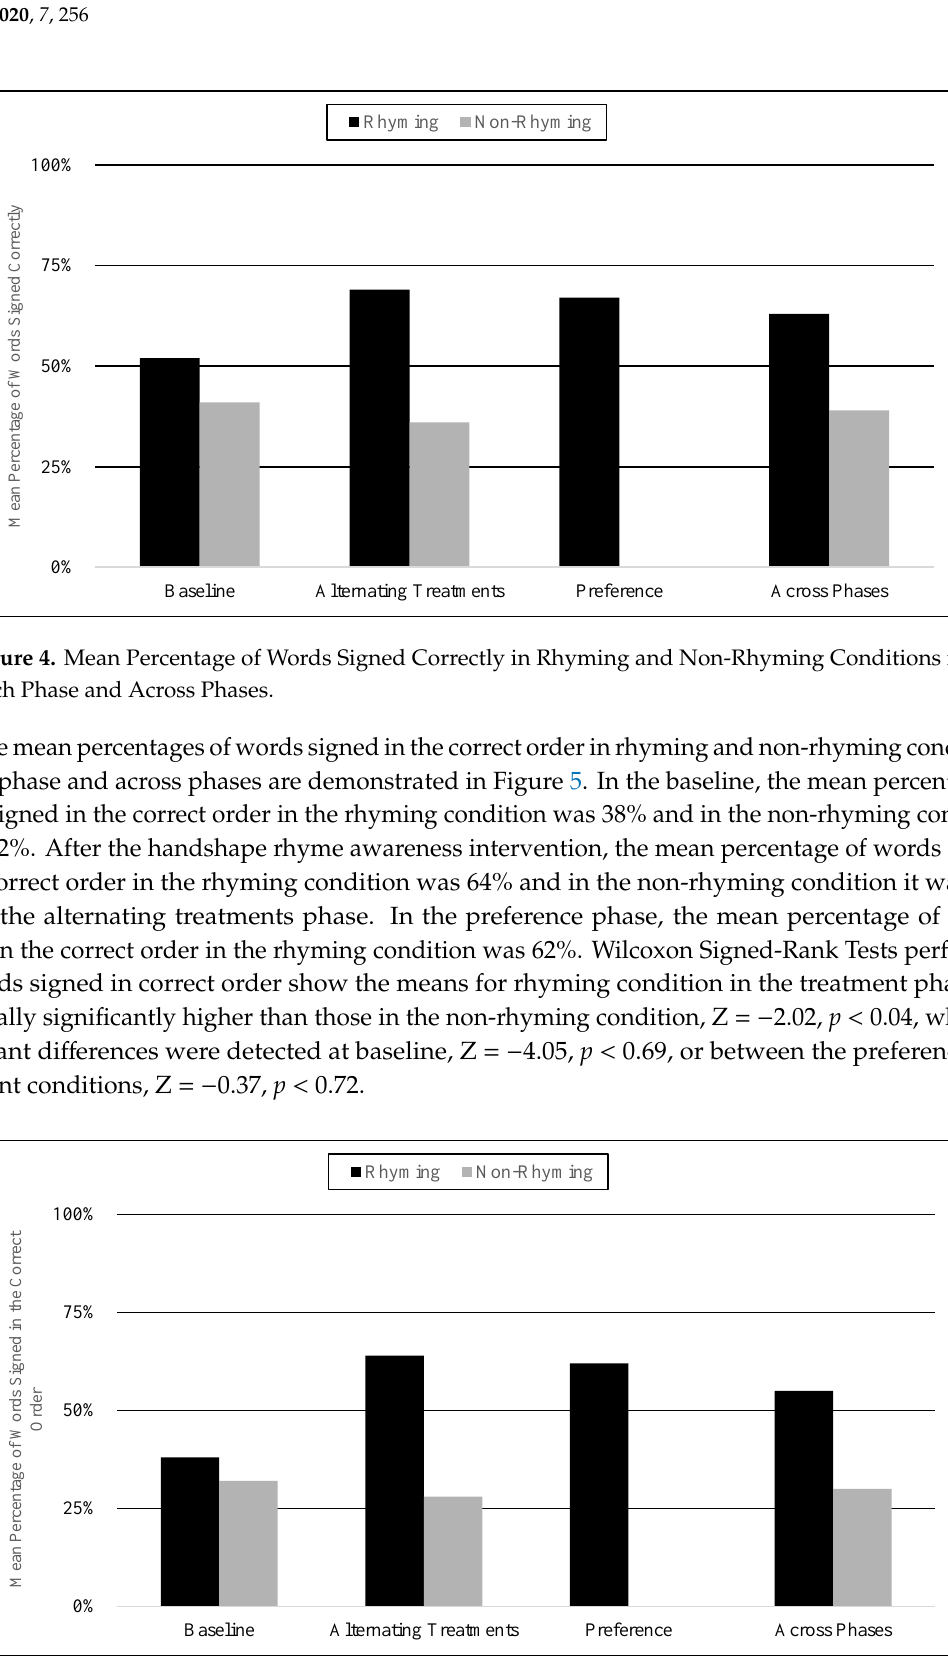
Figure 5. Mean Percentage of Words Signed in the Correct Order in Rhyming and Non-Rhyming Conditions in Each Phase and Across Phases.